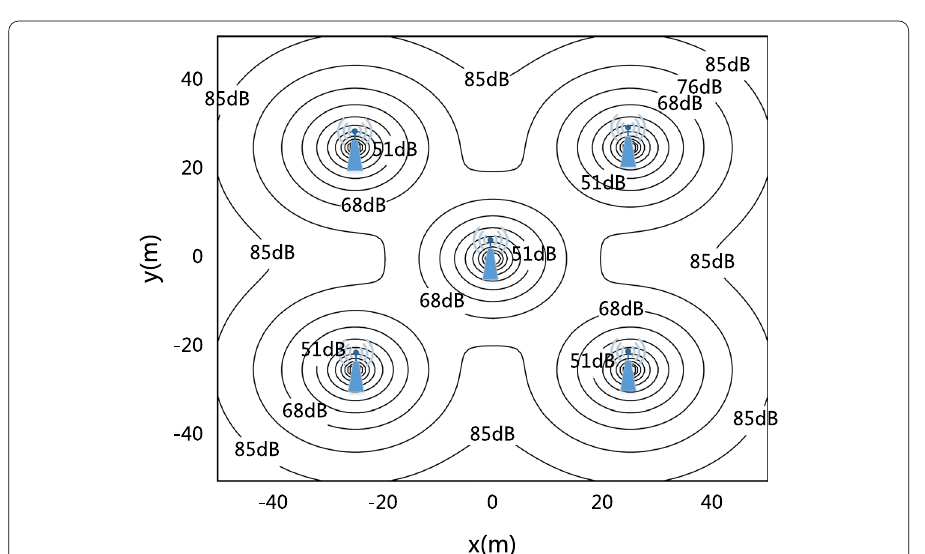
Fig. 1 Illustration of equivalent path loss contour for a cell-free system with five